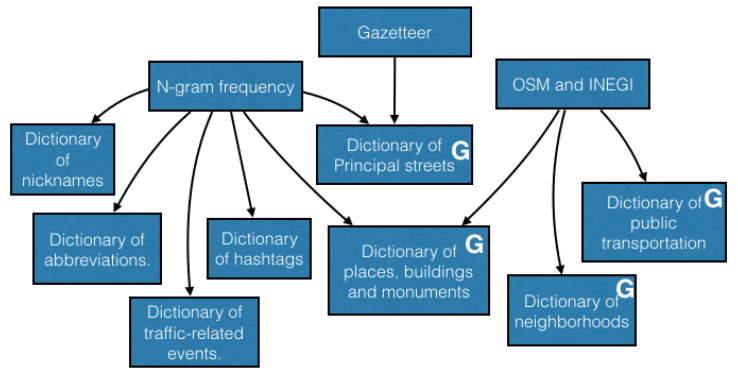
Figure 3. Creation of dictionaries based on information analysis.